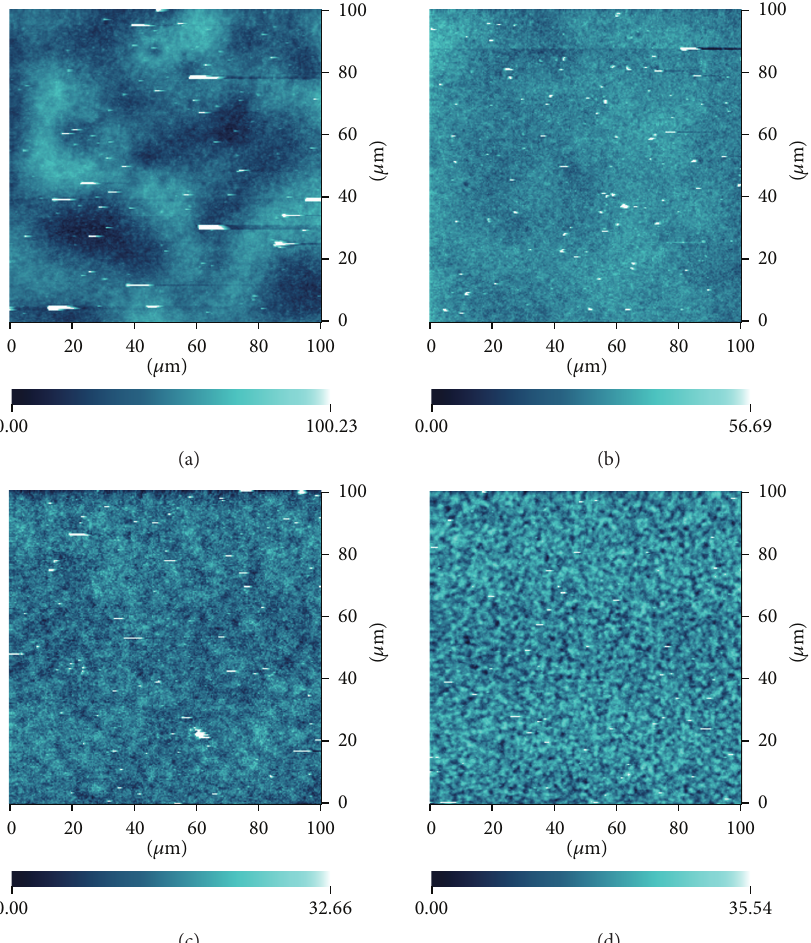
Figure 5: AFM topographies of the PEDOT:PSS thin films coated at different relative humidity from the PEDOT:PSS ink of 80 vol% DMSO.